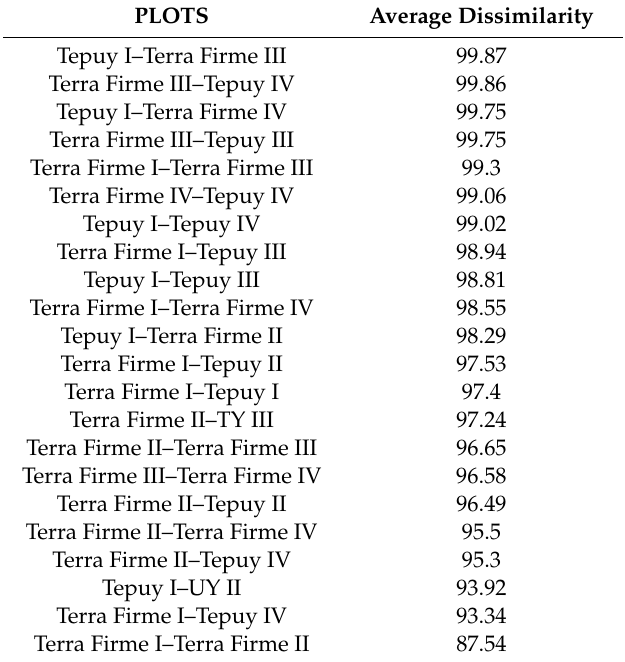
Table 5. Dissimilarity values between the di ff erent types and sampling areas.